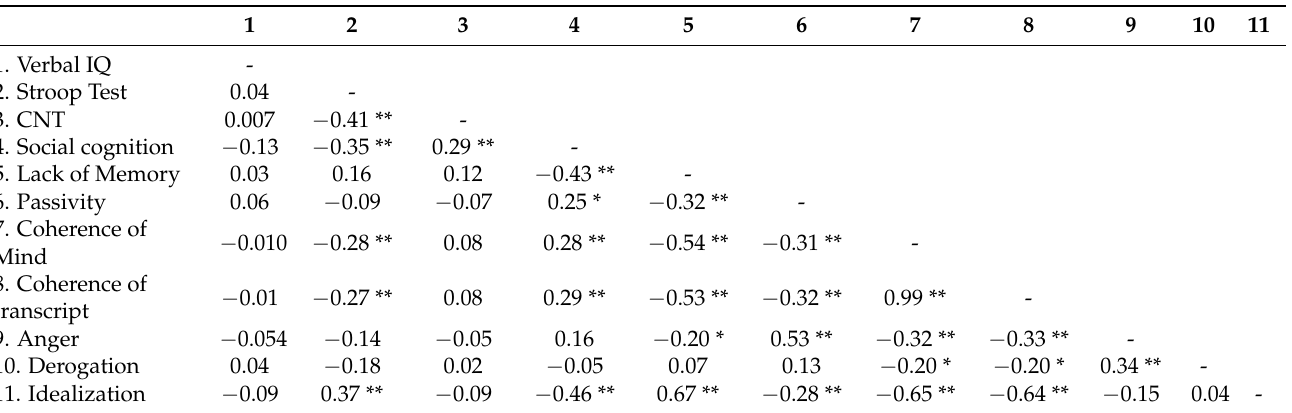
Table 4. Zero Order Correlation between Verbal IQ, attachment state of mind dimensions, executive function and social cognition